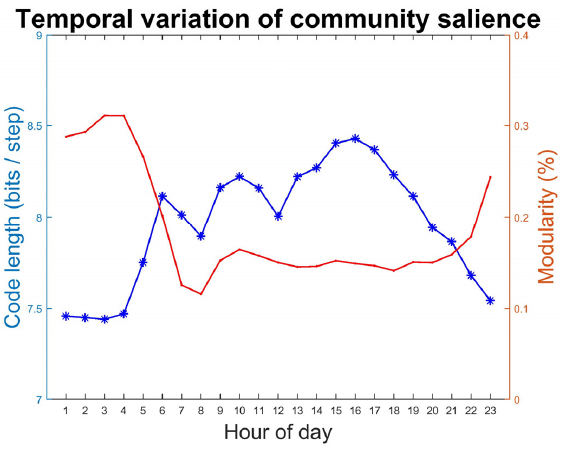
Figure 5. Temporal variation of structure salience.